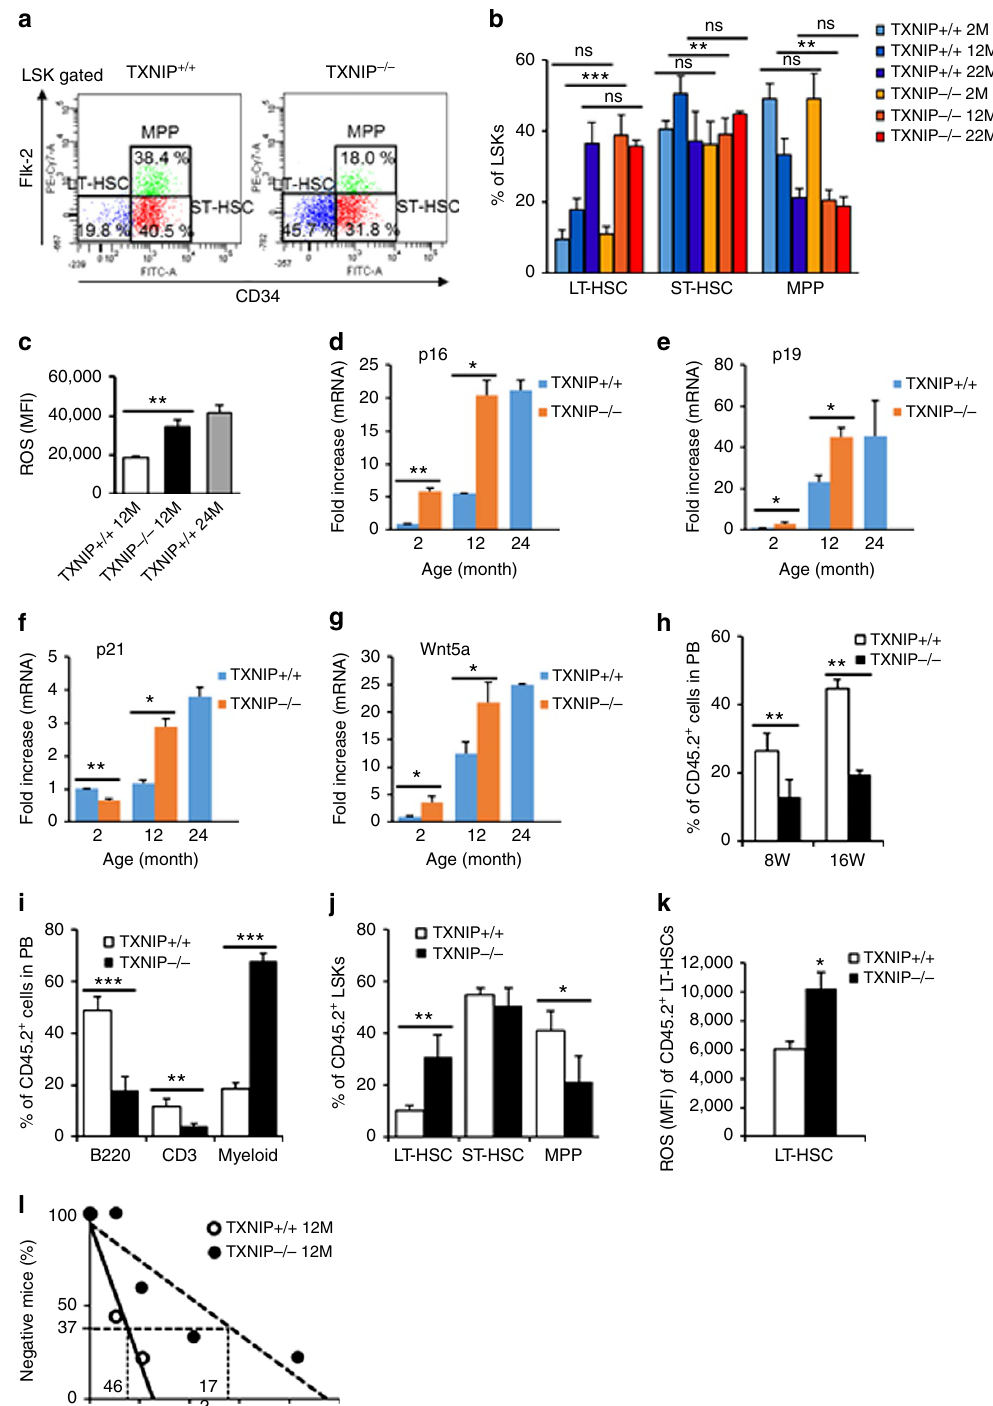
Figure 1 | Premature ageing of TXNIP deficient HSCs. ( a ) A representative image of LT-HSCs, ST-HSCs and MPPs among LSKs in 12-month-old mice. ( b ) LT-HSCs, ST-HSCs and MPPs among LSKs ( n ¼ 6). ( c ) ROS levels in LT-HSCs ( n ¼ 5). ( d – g ) Quantitative real-time PCR of p16 , p19 , p21 and Wnt5a in LT-HSCs ( n ¼ 3). ( h , i ) Distribution of donor-derived WBCs in PB ( h ) and frequency of B220 þ , CD3 þ and myeloid cells among donor-derived WBCs in PB ( i ) ( n ¼ 5 from two experiments). ( j , k ) Frequency of LT-HSCs, ST-HSCs and MPPs among donor-derived LSKs ( j ) and ROS levels of donor-derived